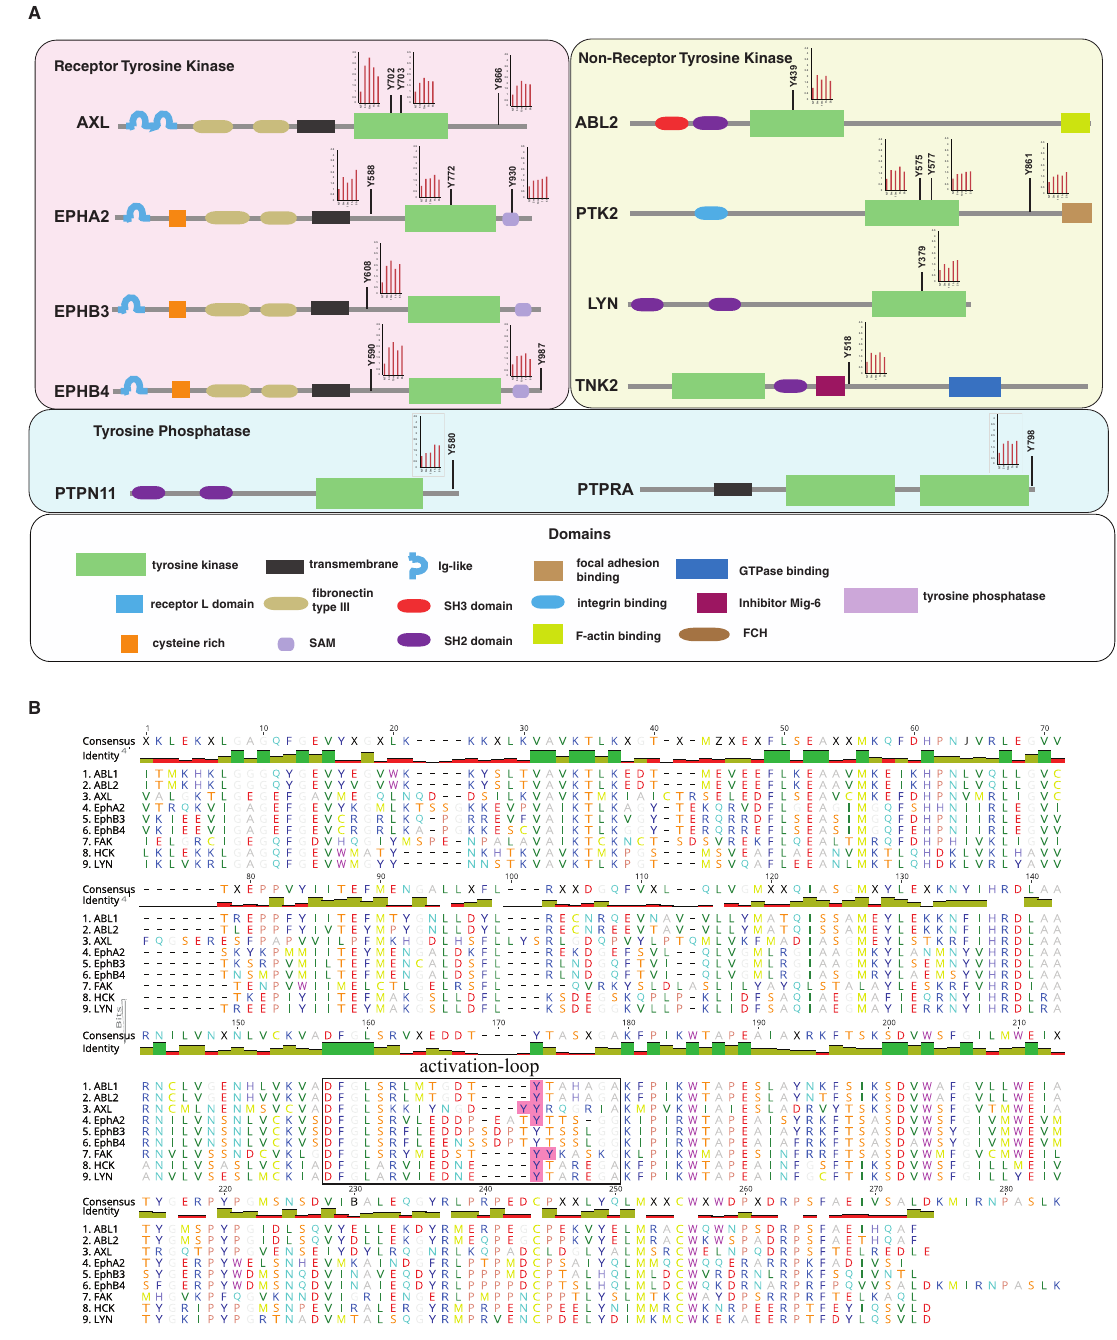
(CRIB) domain; phosphorylation of Tyr518 mediates the interaction between TNK2 and